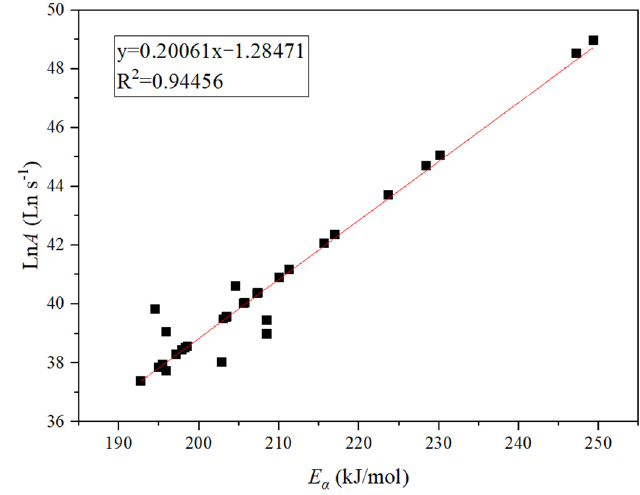
Figure 7. The compensation effect for chicken manure pyrolysis.